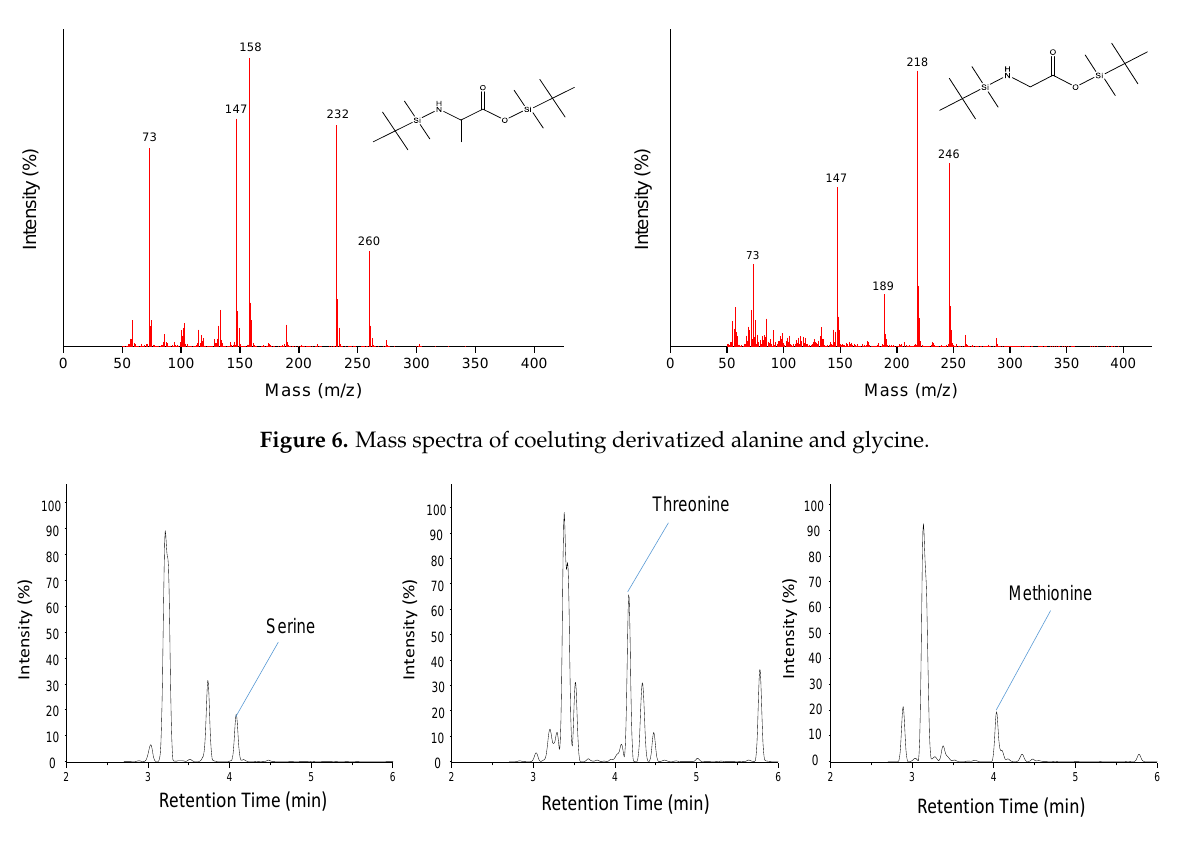
Figure 7. Mass fragmentograms of three compounds serine, threonine and methionine extracted from peak 7 at 4.18 min using specific mass fragments ( m/z 362, 303 and 218, respectively).